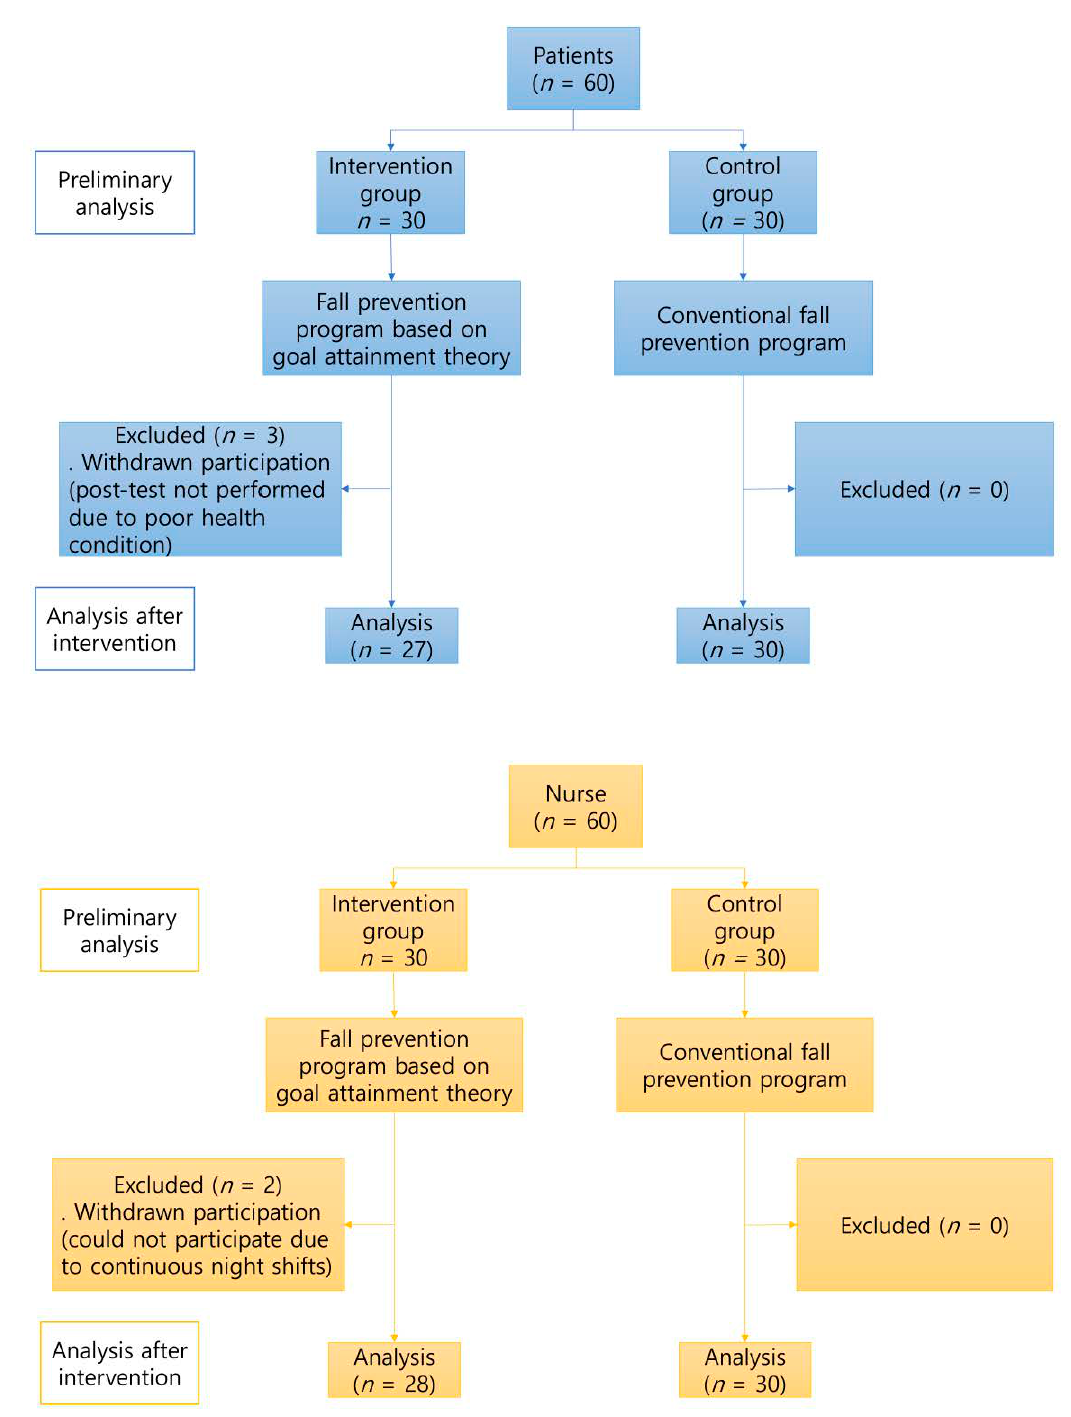
Figure 2. Flow chart of the study.